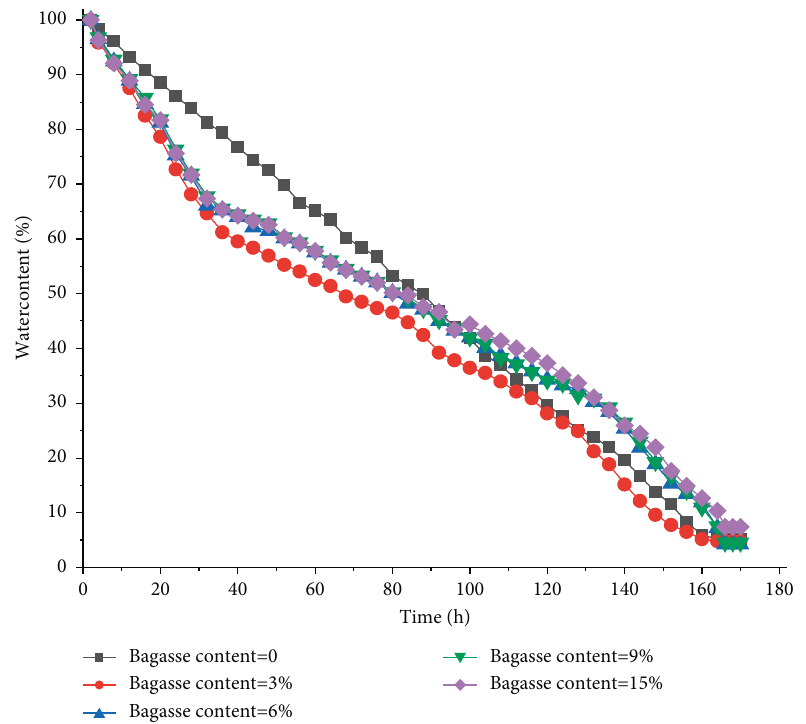
Figure 7: Variation characteristics of clay water content with different bagasse